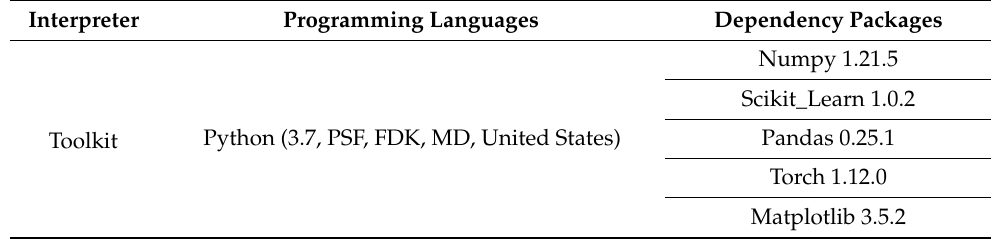
Table 2. Experimental platform and environmental parameters.